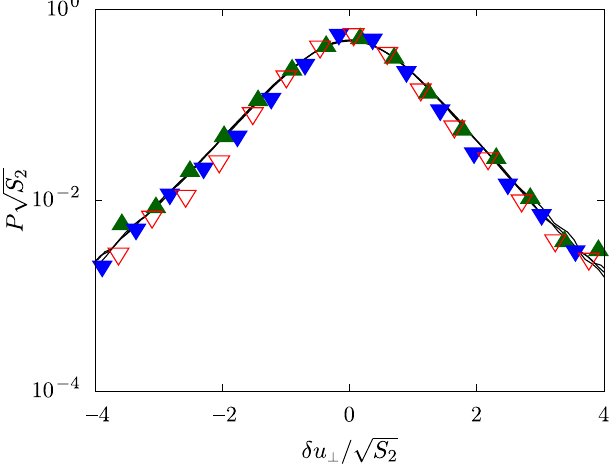
FIG. 7. PDF of the transverse velocity difference evaluated with particle tracking (solid lines) and fiber tracking velocimetry (symbols) for c= L ¼ 0 . 71 (dark green), c= L ¼ 0 . 45 (blue), and c= L ¼ 0 . 57 (red), where L is the integral length scale. The distributions are normalized with the variance of the velocity differences at the corresponding separation evaluated through the standard 3D-PTV technique. Turbulence is generated by rough wheels rotating at 400 rpm. The corresponding Reynolds number based on the Taylor microscale Re λ ¼ 146 , while the one based on the integral length scale Re L ¼ 1410 . Other relevant param- eters are summarized in Ref.